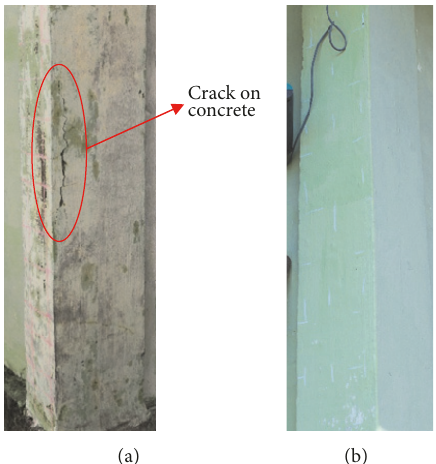
Figure 15: The visual of a column of Object III for (a) directly facing to the sea and (b) facing to the opposite of sea.